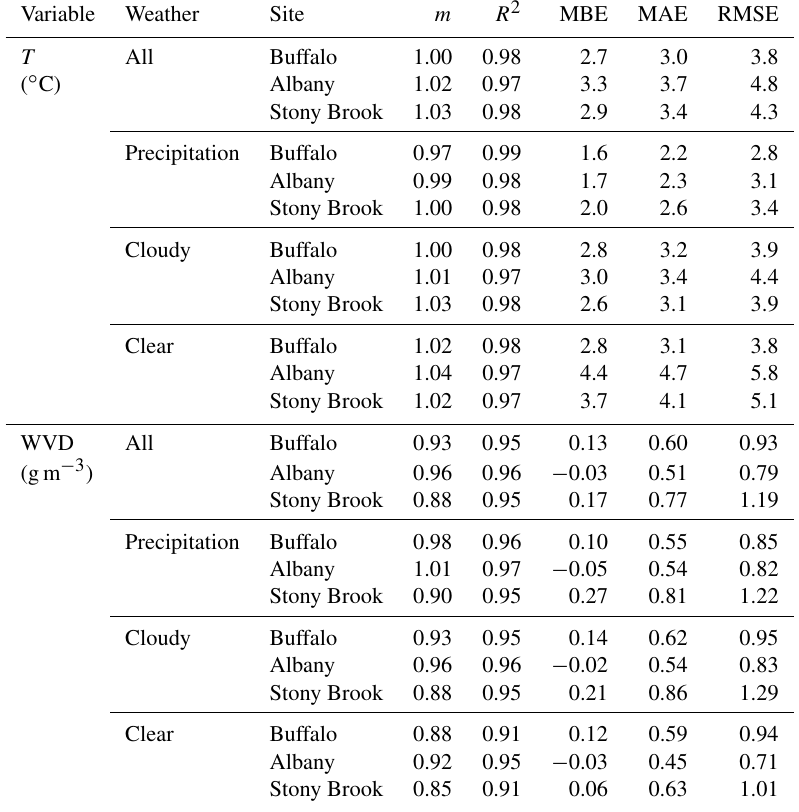
Table 4. Comparison statistics between radiosondes and MWR data based on weather condition from January 2018 to August 2021. Variable